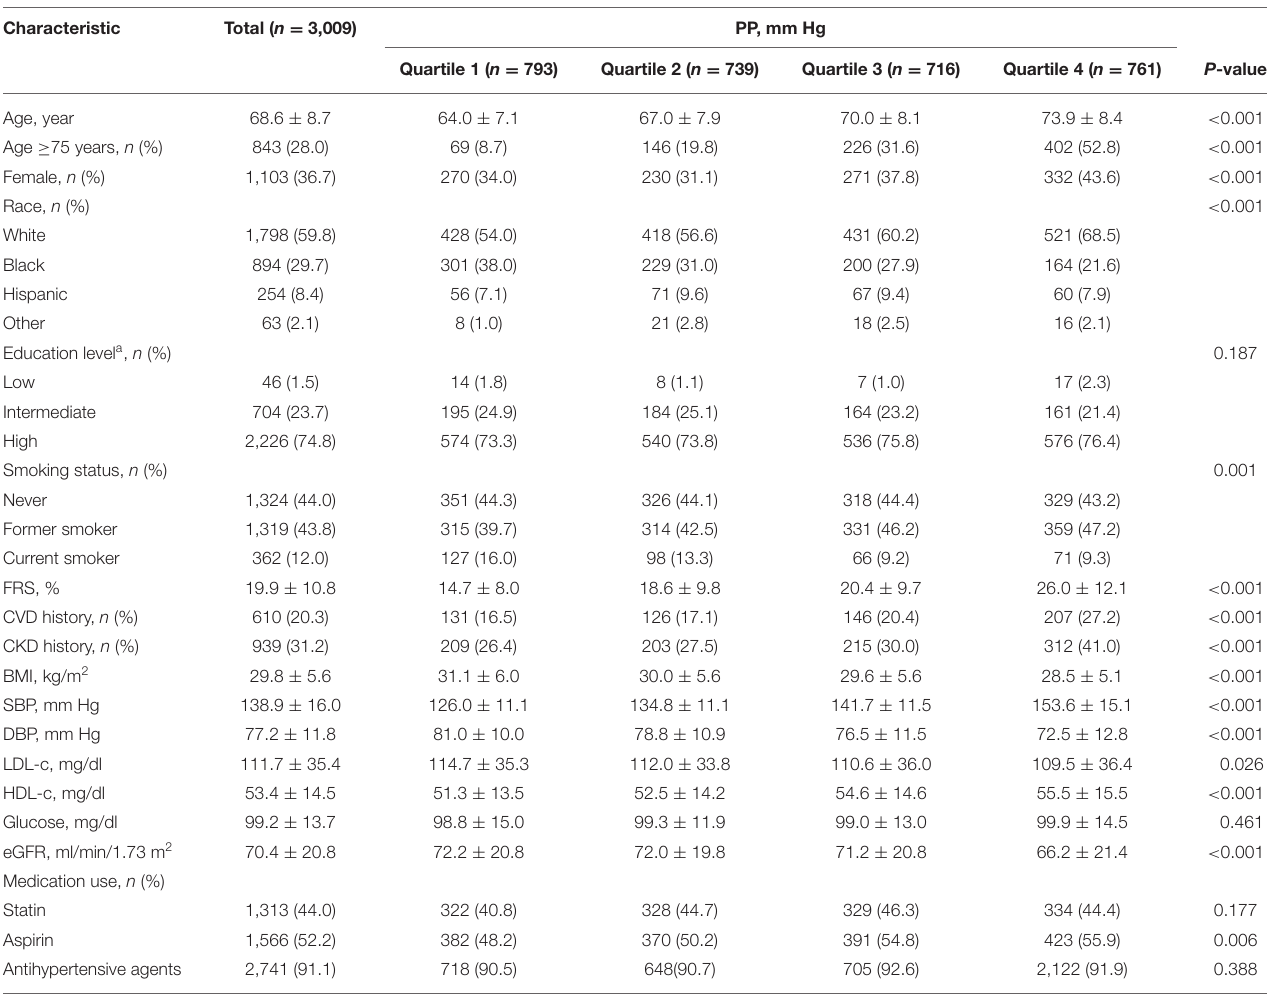
TABLE 1 | Baseline characteristics of Systolic BP Intervention Trial-Memory and cognition IN Decreased hypertension (SPRINT-MIND) participants classified by pulse rressure (PP) quartile.